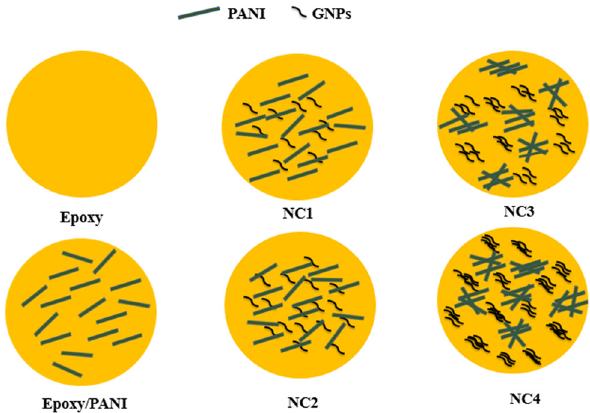
Figure 9: Schematic diagram of epoxy, epoxy/PANI, and epoxy/ GNPs/PANI